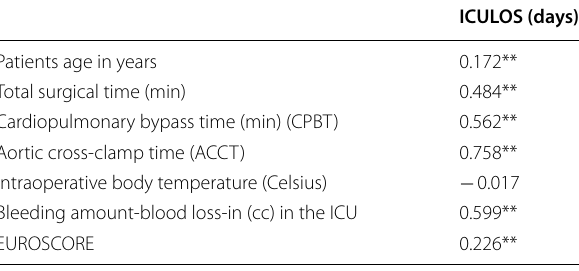
** p value is 0.010, * p value ≤